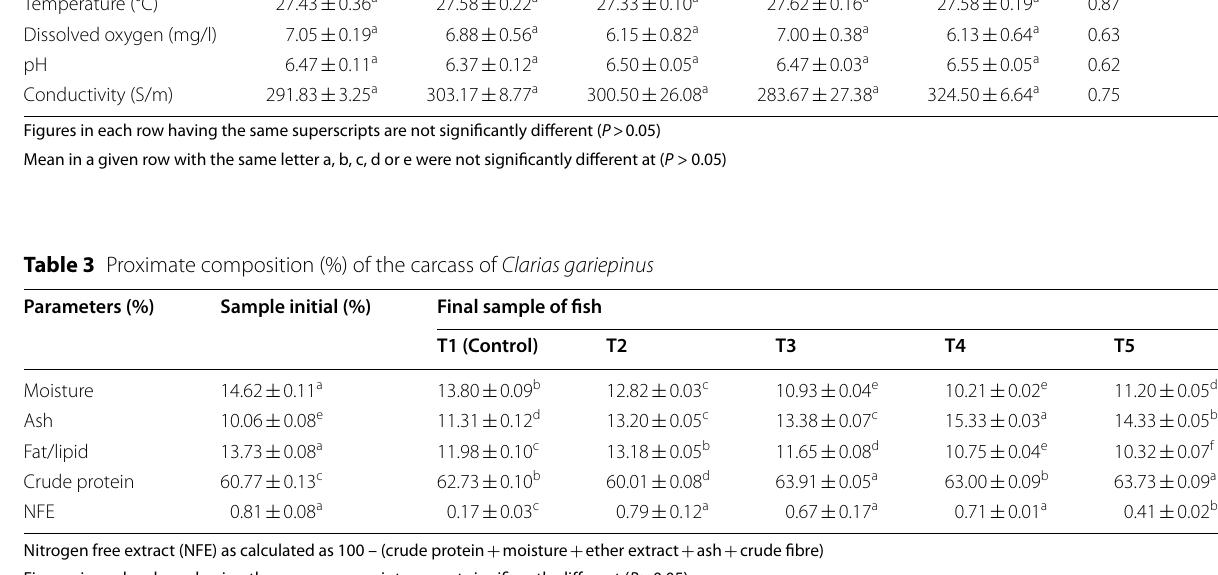
moisture ether extract ash crude fibre) + + + +